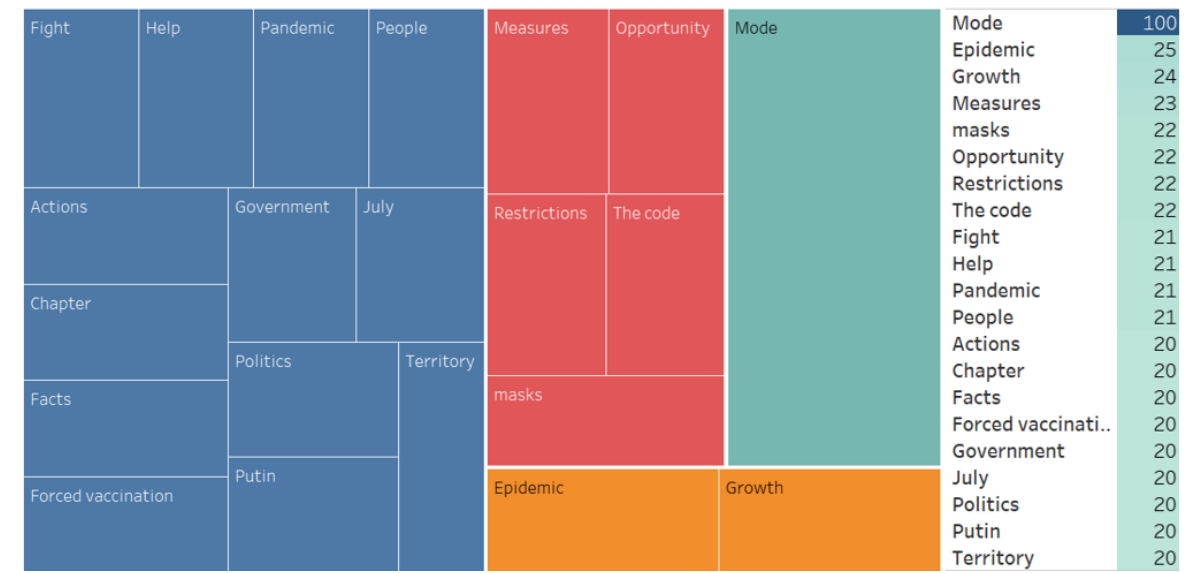
Figure 8. Associative network of the “Distance learning for universities” stimulus in the negative cluster.